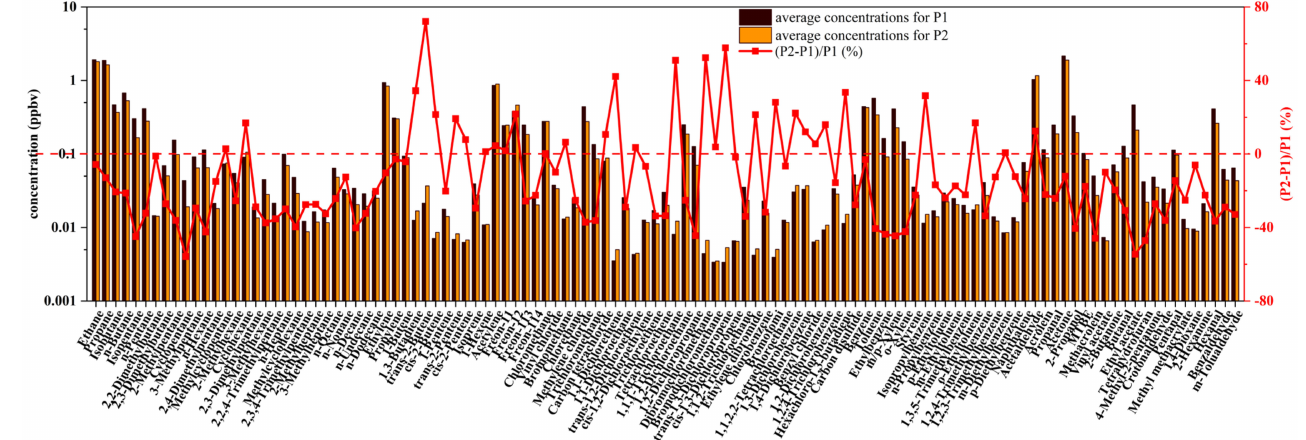
Figure 2. Average concentrations of VOC species during nonheating (P1) and heating (P2) periods and the relative differences between these two periods.